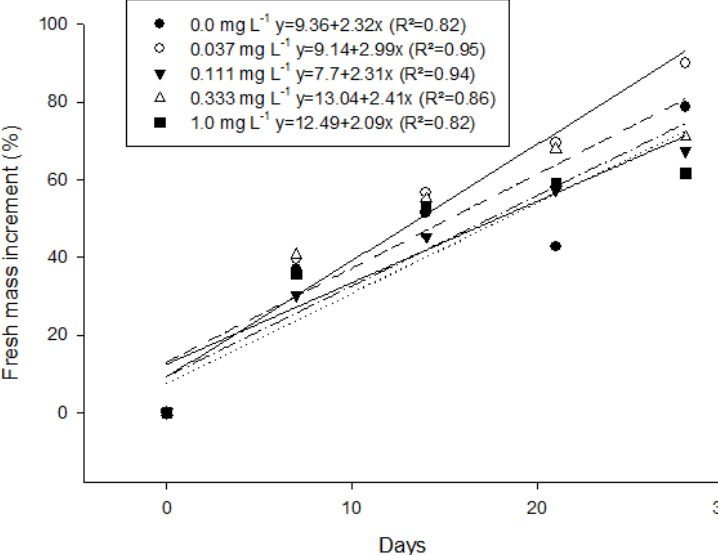
Figure 4. Fresh mass (%) of P. stratiotes following clomazone application. Means of values of fresh mass refer to control (without herbicide): 0 day = 123.75 g; 7 th day = 169.46 g; 14 th day = 187.52 g; 21 st day = 176.53 g and 28 th = 221.03